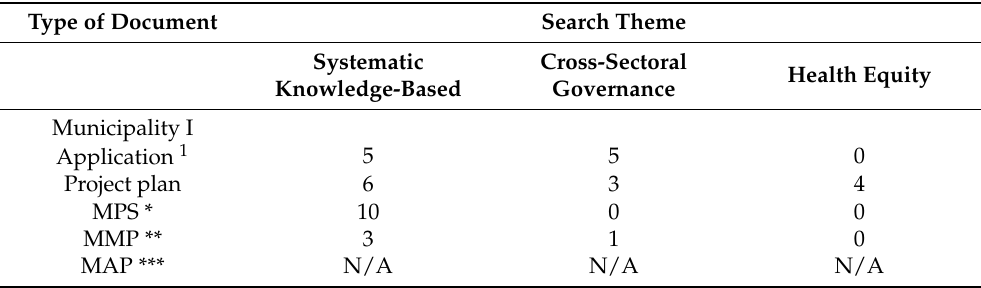
Table 2. Frequency of the themes of systematic knowledge-based approach, cross-sectoral governance, and health equity in municipal plans and project